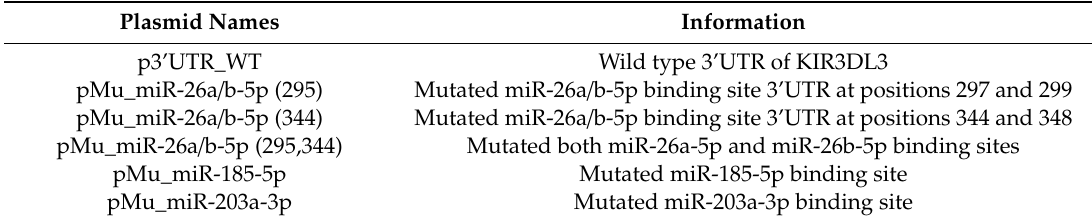
Table 1. List of plasmid